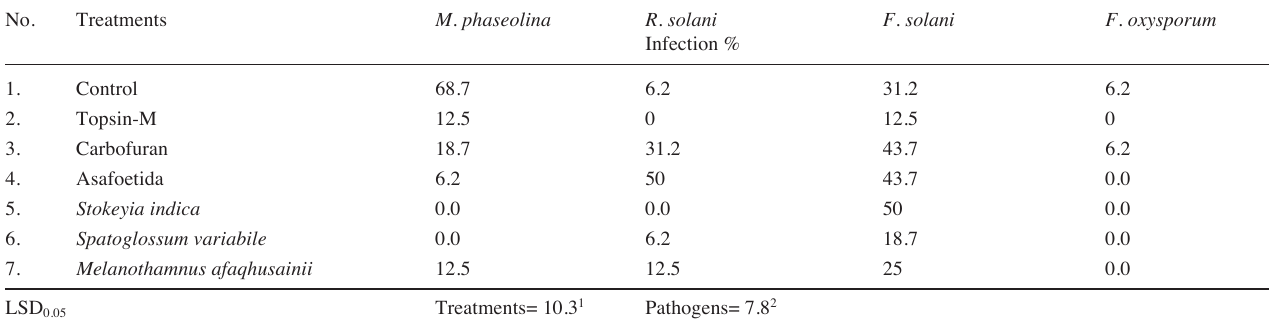
Tab. 1: Effect of asafoetida and seaweed on the infection of root infecting fungi on eggplant in field plot experiment.